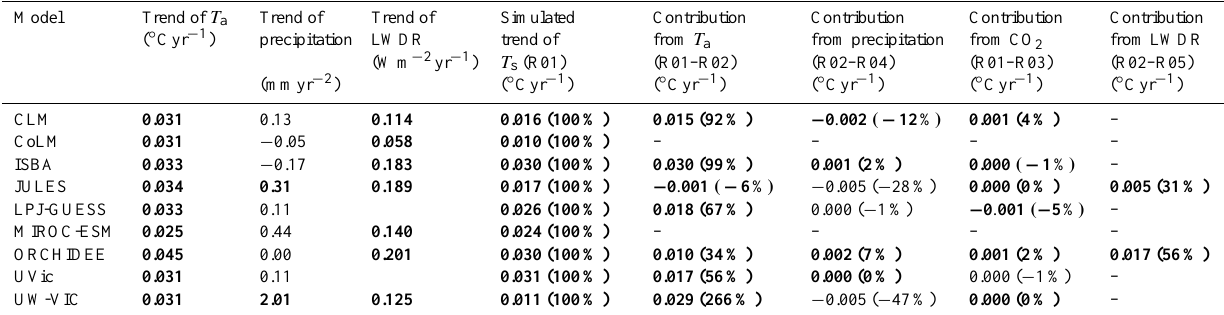
Table 3. The trends of annual air temperature ( T a ) , precipitation, and longwave downward radiation (LWDR) in the second to fourth columns. The fifth column shows the trends of annual T s at 20cm in the reference simulation (R01). The last four columns show the contributions of drivers ( T a , precipitation, CO 2 , and LWDR) to the trend of T s as mentioned in the Methods section. The relative contributions (divided by the trend of T s in Ref) are shown in the parentheses. The bold font indicates statistical significance ( P <0.05). Model